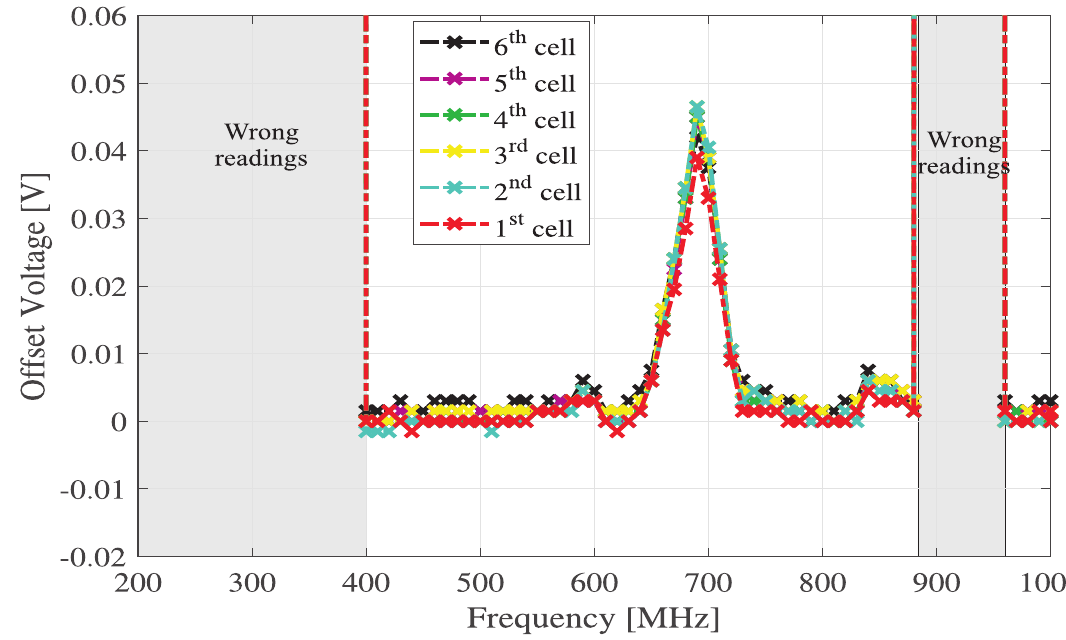
Figure 14. EMI-induced offset in the cell voltage readings. Antenna in front of the EUT (Figure 12). Horizontal polarization.